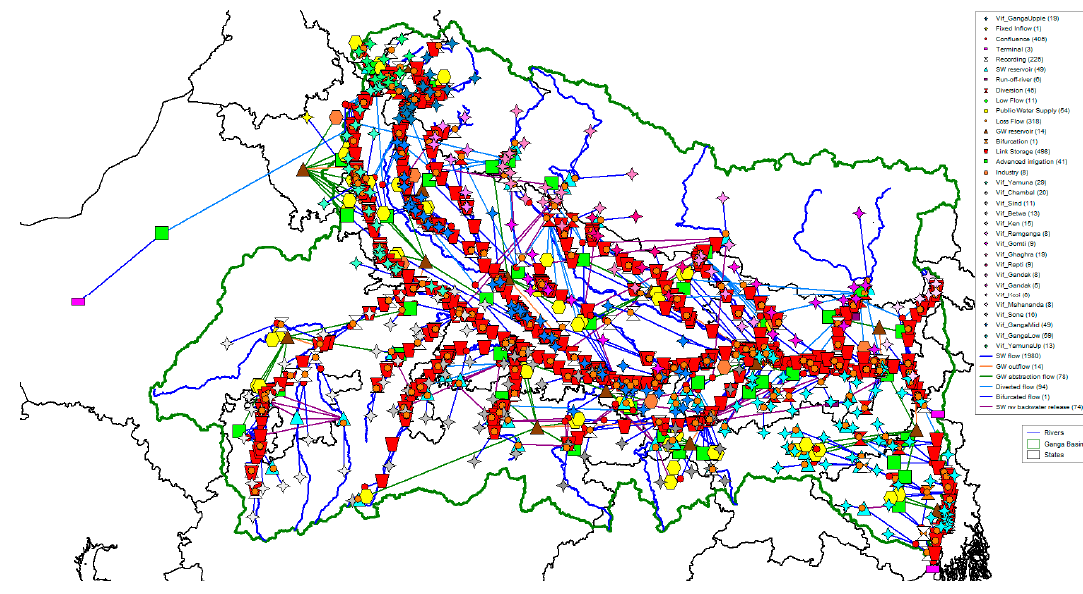
Figure 5. Schematization of the Ganga River Basin in RIBASIM.